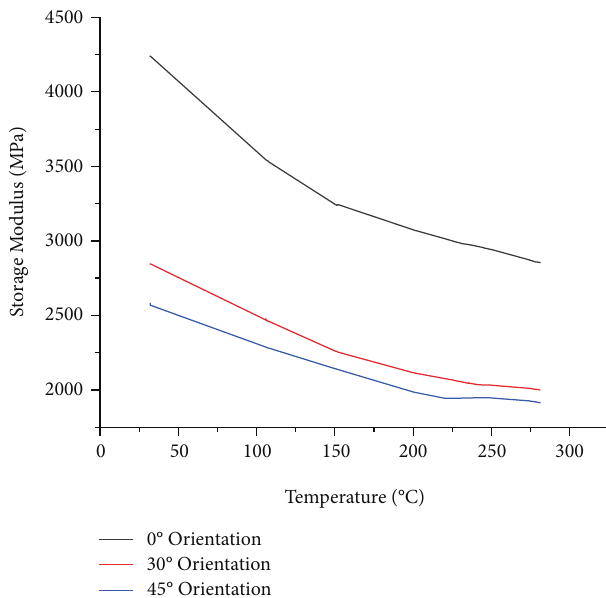
Figure 2: Temperature versus storage modulus of the basalt fi ber reinforced with anamide composites at di ff erent orientations and a frequency of 1 Hz.